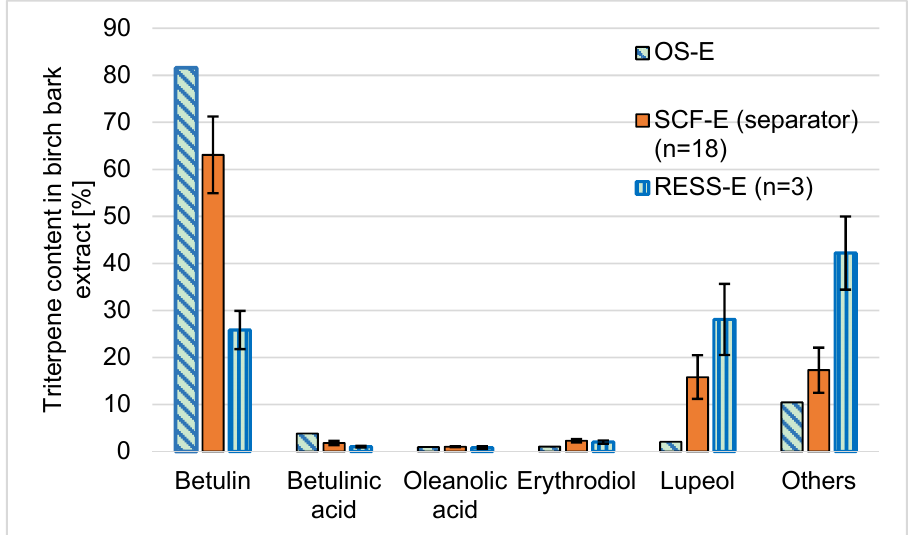
Figure 3. Triterpene composition of birch bark extract obtained by different extraction methods; mean ± SD.